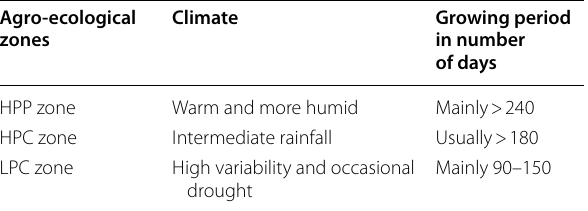
Table 2 Major Agro-Ecological Zones of the Ethiopian